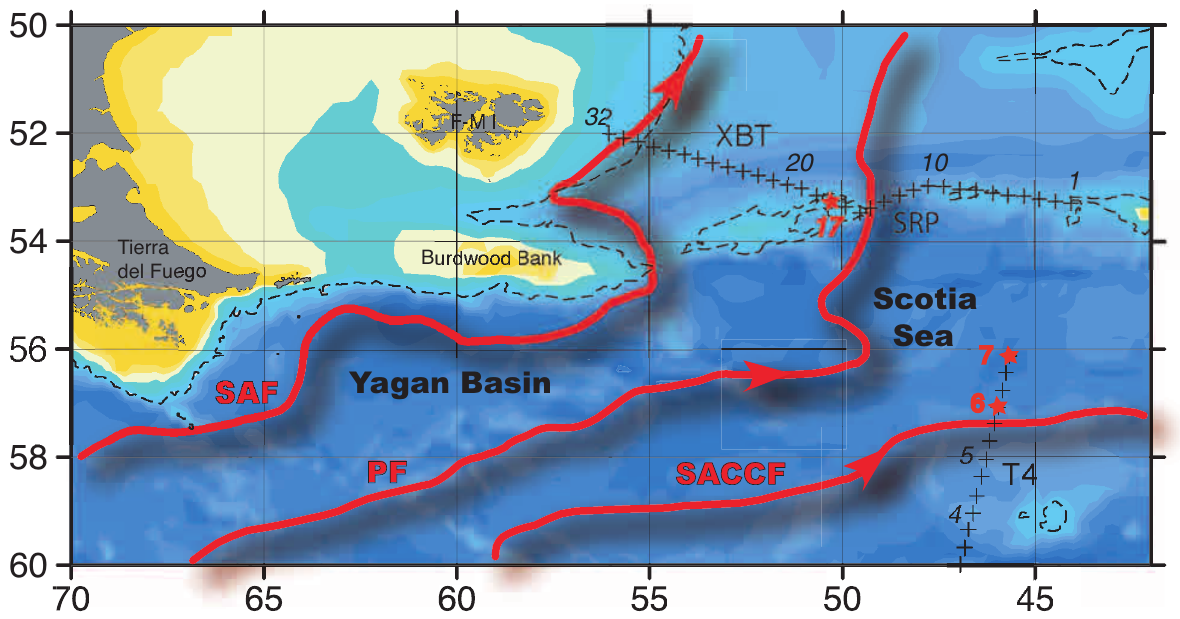
F IG . 1. – Topographic map of the southern southwest Atlantic (SSWA) depicting the Shag Rocks Passage (SRP). The red lines indicate the mean position of the sub-Antarctic Front (SAF), the Polar Front (PF) and the Southern Antarctic Circumpolar Current Front (SACCF)